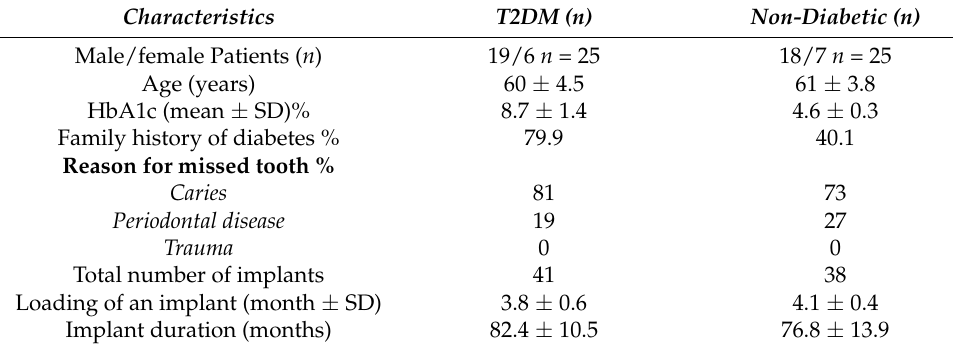
Table 1. General characteristics of the cohort